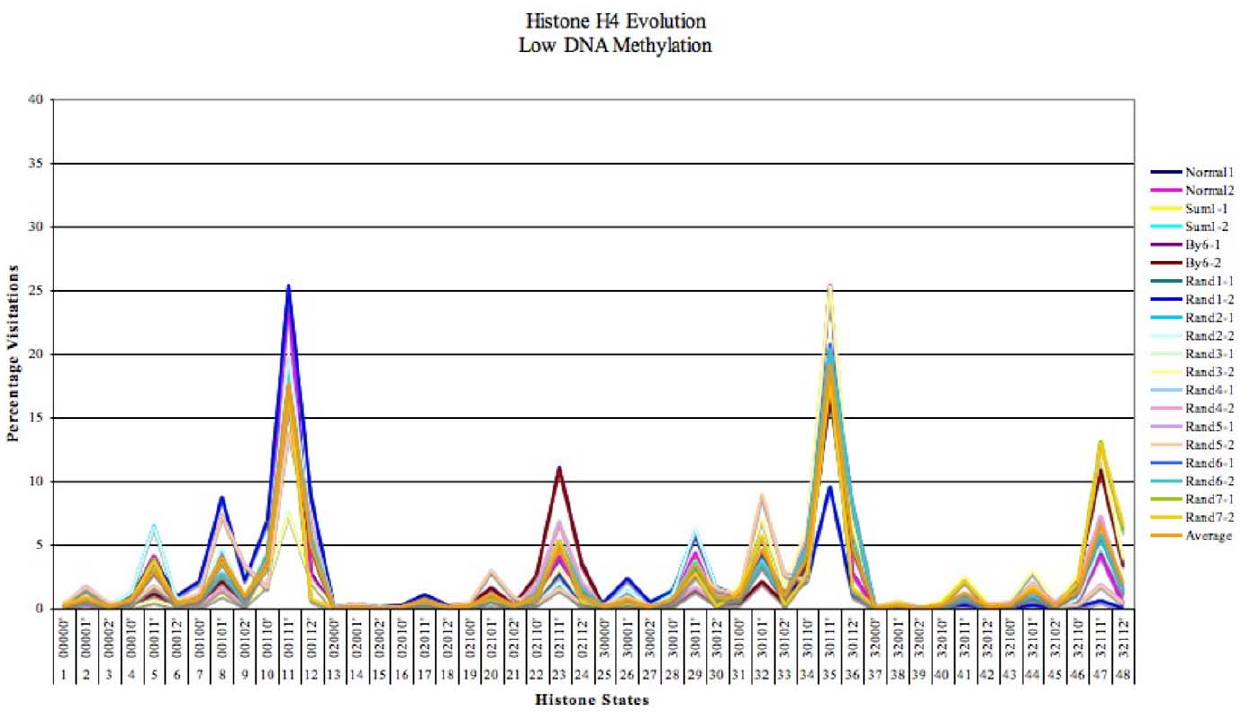
Figure 5. Evolution of H4 (H4-1 and H4-2) histone states in the 16 promoters for 10 different datasets during low DNA methylation levels ( , 0.15 or 15%). H4-1 and H4-2 histone states were tested with 10 datasets of random probability values (represented by colors in the graph).